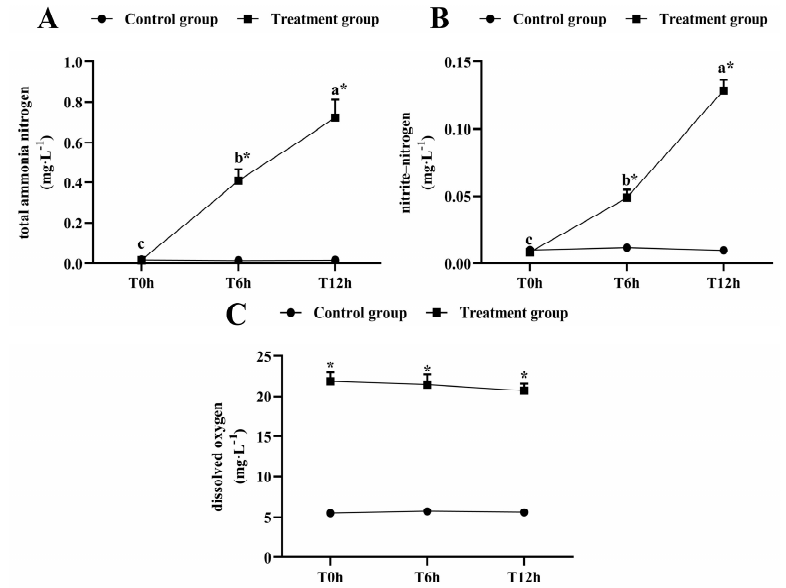
Figure 1. Changes in total ammonia-nitrogen ( A ) nitrite-nitrogen ( B ) and dissolved oxygen ( C ) levels during transport. T0h: transport stress at 0 h; T6h: transport stress at 6 h; T12h: transport stress at 12 h. * significant difference between control and treatment groups (paired samples t -test, *: p < 0.05). Lowercase letters indicate significant differences ( p < 0.05) between treatments (Duncan’s multiple range test).